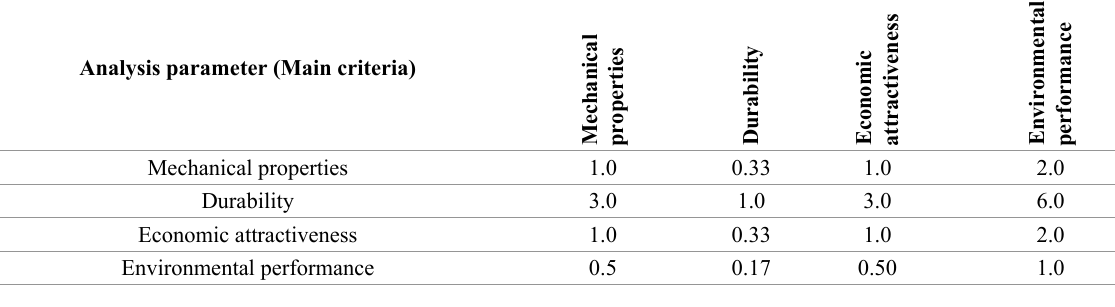
Analysis parameter (Main